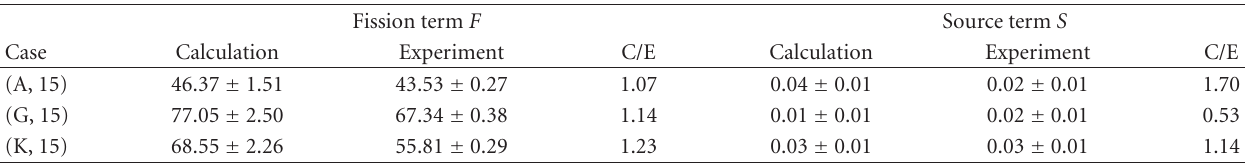
Table 3: Comparison between the measured and calculated fission and source terms obtained from the experiments (Figure 5) and calculations (MCNPX with JENDL/HE-2007).